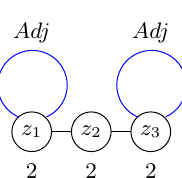
Figure 14 . P (4) quiver with A 3 (cid:24) = D 3 global symmetry, b = 0, dim M H [2 2 ]